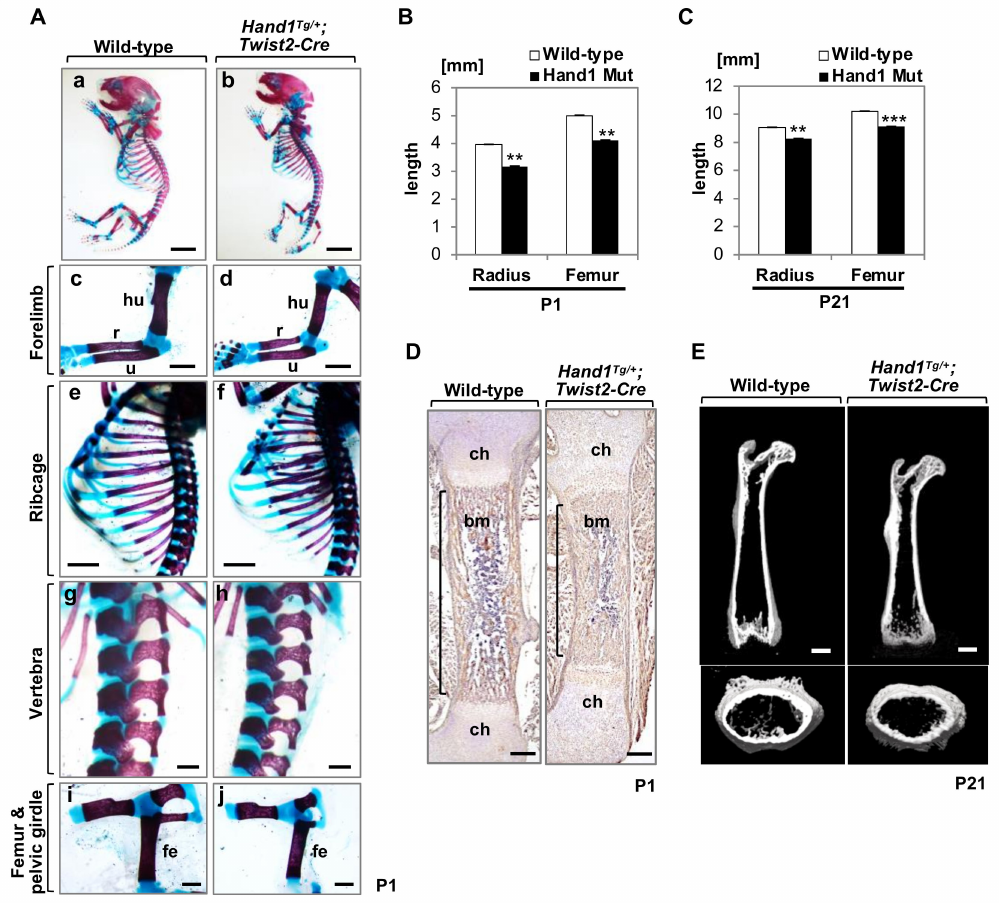
Figure 1. Hand1 overexpression a ff ects the morphology and size of long bones. ( A ) Staining of bones from wild-type and Hand1 -overexpressing mice at postnatal day (P)1. hu, humerus; r, radius; u, ulna; fe, femur. Scale bars: 4 mm ( a , b ); 1 mm ( c , d , i , j ); 2 mm ( e , f ); 500 µ m ( g , h ). ( B , C ) The lengths of the radius and femur bones of wild-type and Hand1 -overexpressing mice at P1 ( B ) and P21 ( C ). The lengths of long bones from Hand1 -overexpressing mice decreased compared to that of wild-type mice. n = 3, ** p < 0.01, *** p < 0.001. ( D ) Immunohistochemical staining for MMP13 in femurs from wild-type and Hand1 -overexpressing mice at P1. Osteogenesis domain (shown in brackets) is hypoplastic in Hand1 -overexpressing femurs. Scale bars: 200 µ m. ( E ) Micro-computed tomography (micro-CT) analysis of femurs from wild-type and Hand1 -overexpressing mice at postnatal day P21. Scale bars: 1